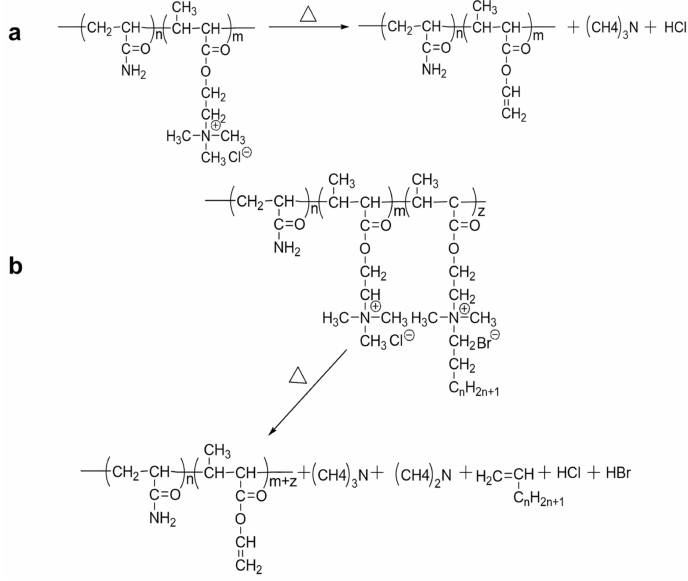
Figure 5. The Hofmann elimination reaction for ( a ) P(AM- co -DMC) and ( b ) HAPAM at high